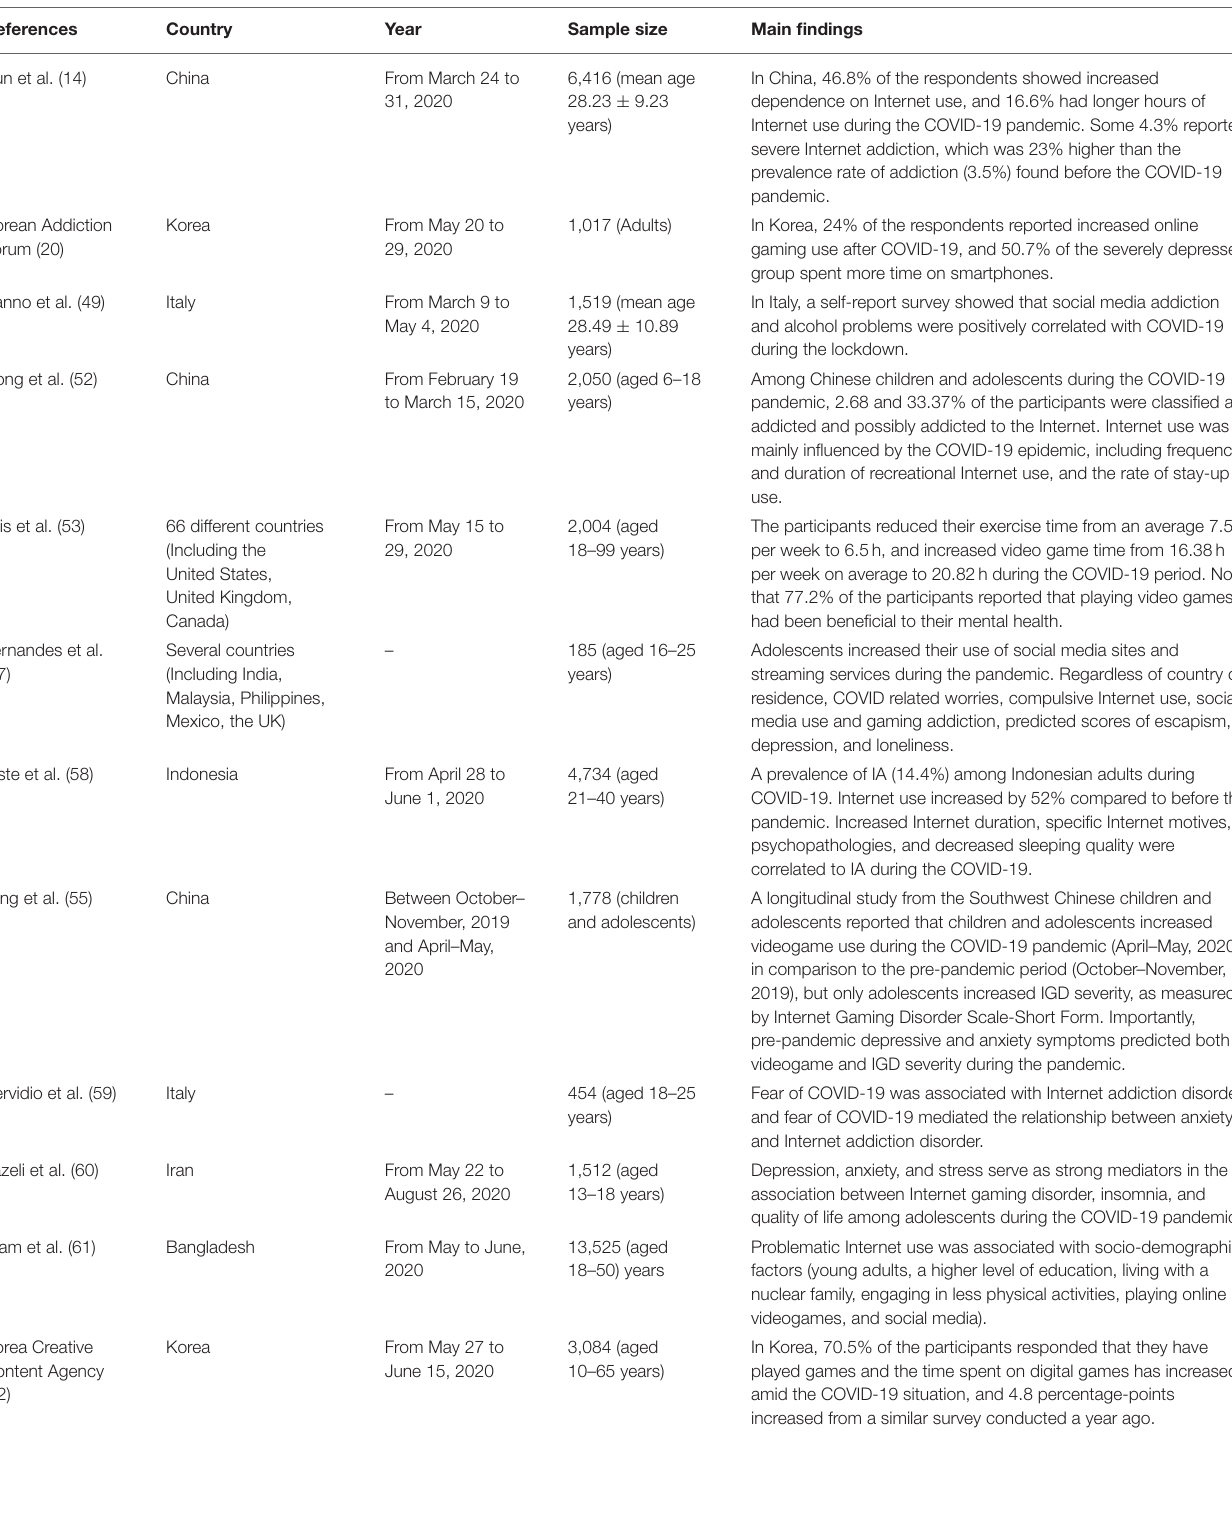
TABLE 2 | Literature review of online gaming use during the COVID-19